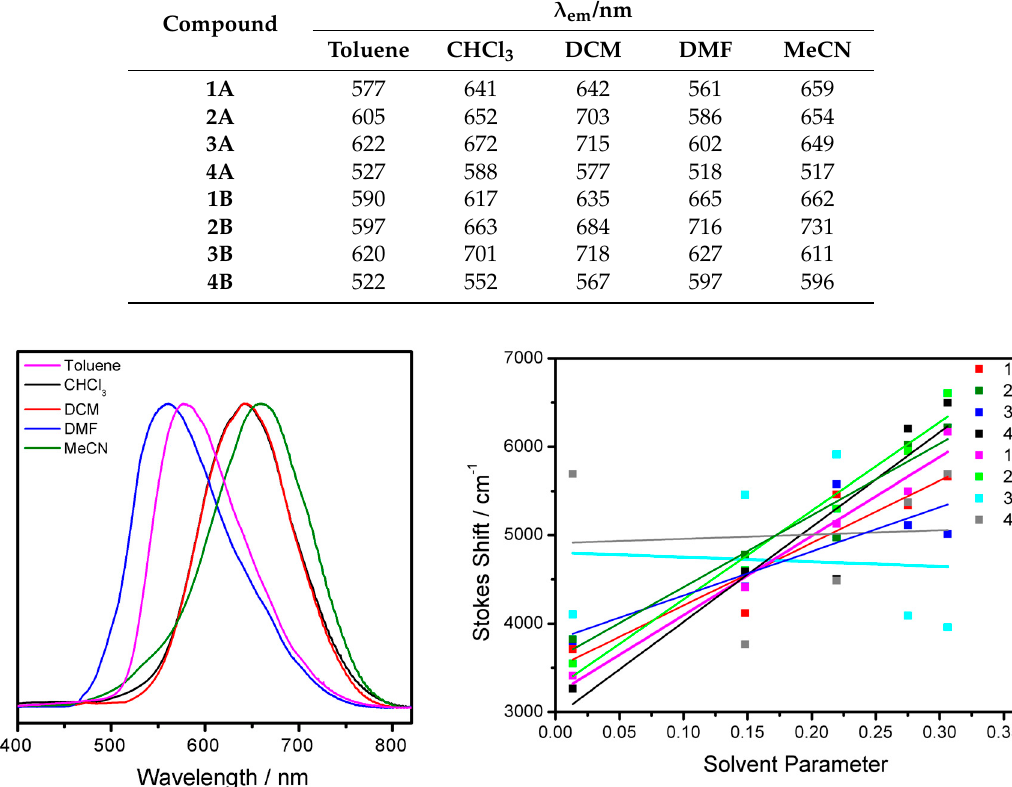
Table 3. The emission maximum observed for the compounds studied in a range of solvents. Compound